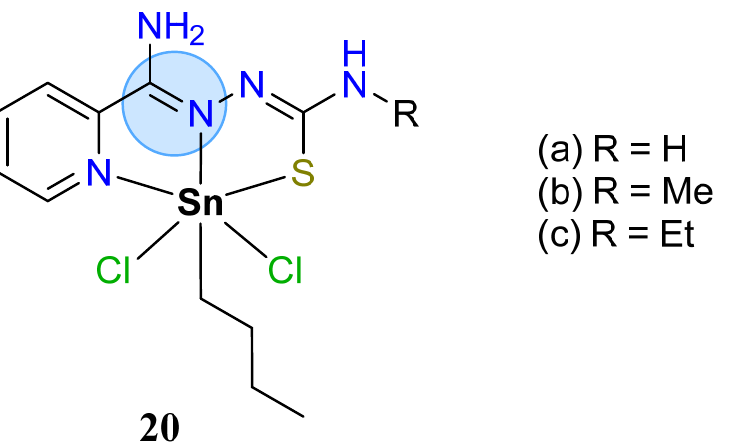
Figure 11. n-Butyltin(IV) complexes with ligands derived from 2-pyridineformamide thiosemicar- Figure 11. n ‐ Butyltin(IV) complexes with ligands derived from 2 ‐ pyridineformamide thiosemi ‐ bazone studied in antimicrobial carbazone studied in antimicrobial activity.